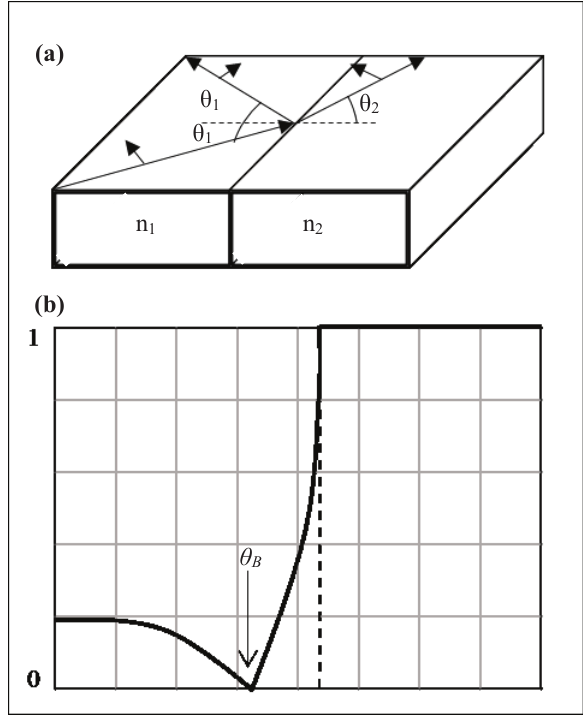
Fig. 3. (a) Magnitude of p-polarized waves for internal reflection (b) The magnitude vanished at the Brewster angle